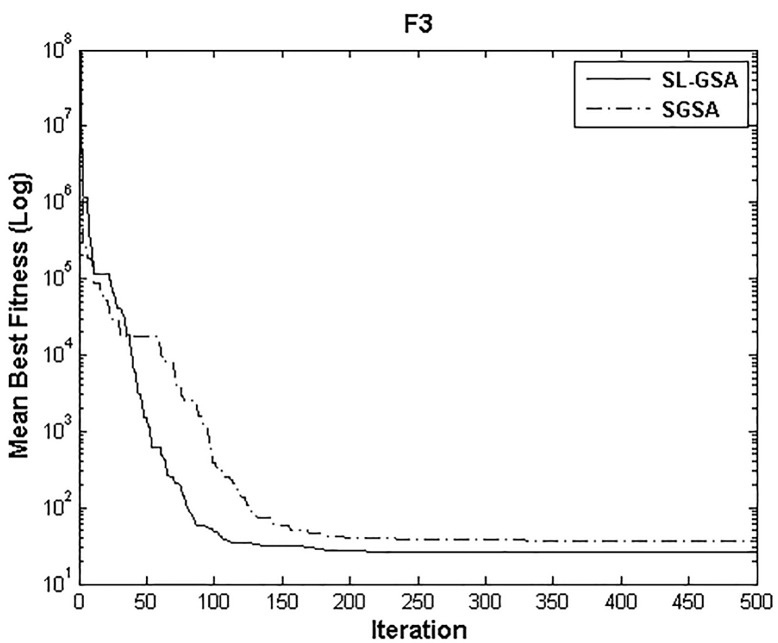
Performance comparison of SGSA and SL-GSA for minimization of F3.